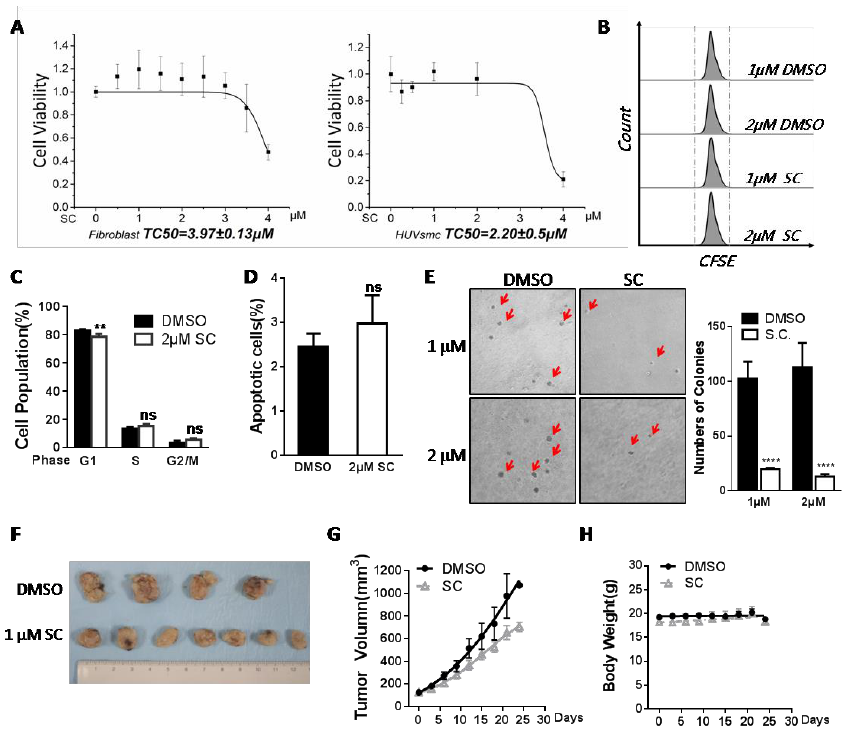
Figure 6. Application of SC to the inhibition of tumor formation. ( A ) the CCK-8 assay showed no proliferative inhibitory effect of SC in human primary skin fibroblast cells (left) and HUVSMC (right) at the concentration that was effective in inhibiting telomerase activity in cancer cells (data shown in Figure 3, IC50 to telomerase=1.21 μM). ( B ) Human PBMCs were measured by CFSE labeling and then treated with 2 μM SC for 72 h. The similar characteristics of the histograms indicate that SC does not affect the proliferation of PBMCs. ( C ) Cell cycle PI staining assay was performed in fibroblast with 2 μM of compound. ( D ) Apoptosis analysis for human fibroblasts following SC treatment. ( E ) Representative photographs of the colonies from the soft agar colony formation assay in MDA-MB-231 cells treated with SC or DMSO (control). The red arrows indicate the formed cell colonies. The statistical number of colonies formed in ten randomly visual fields was quantified. ( F , H ) MDA-MB-231 cells were used to establish an orthotopic xenograft model in nude mice. Here, 1 μM blood concentration of SC or DMSO (vehicle) was injected into the tail vein. The total blood volume of a mouse was estimated as 7% of the body weight. A representative